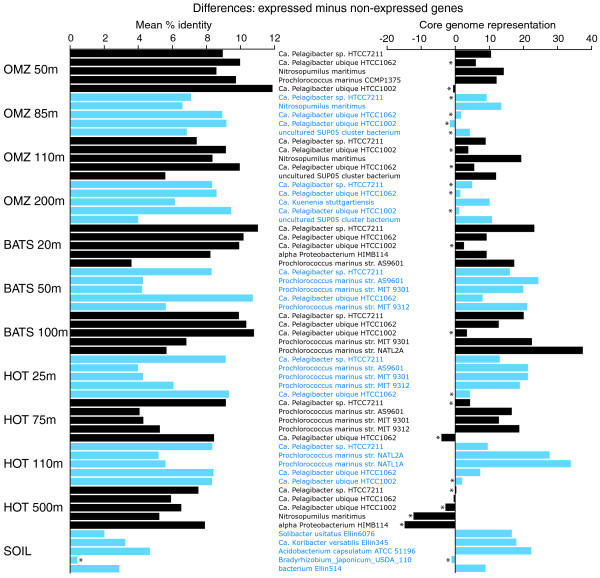
Expressed and non-expressed genes differ in amino acid identity (left) and core genome representation (right). Data are from DNA sequence sets and include the five most abundant taxa per sample, with taxon abundance determined by the proportion of total reads with top matches to protein-coding genes in each genome (BLASTX of all DNA reads against NCBI-nr). 'Core genome representation' is calculated as the percentage of each gene set (that is, expressed or non-expressed genes) falling within the core genome of each taxon, as defined in the text. All differences (left and right panels) are significant (P < 0.001), unless marked with an asterisk.